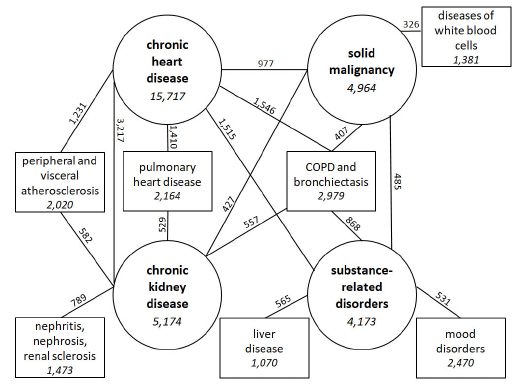
Figure 1: Four most prevalent comorbidities and their most prevalent combined comorbidities. The four most prevalent co- morbidities, occurring in >10% of the patients (chronic heart dis- ease, chronic kidney disease, solid malignancy, substance-related disorders) are displayed in the circles, and bound to their five most prevalent comorbidities, displayed in the squares. The numbers in the circles and in the squares are the number of patients with the comorbidity. The numbers beside the lines are the number of pa- tients with the combined comorbidities.COPD = chronic obstructive pulmonary disease.